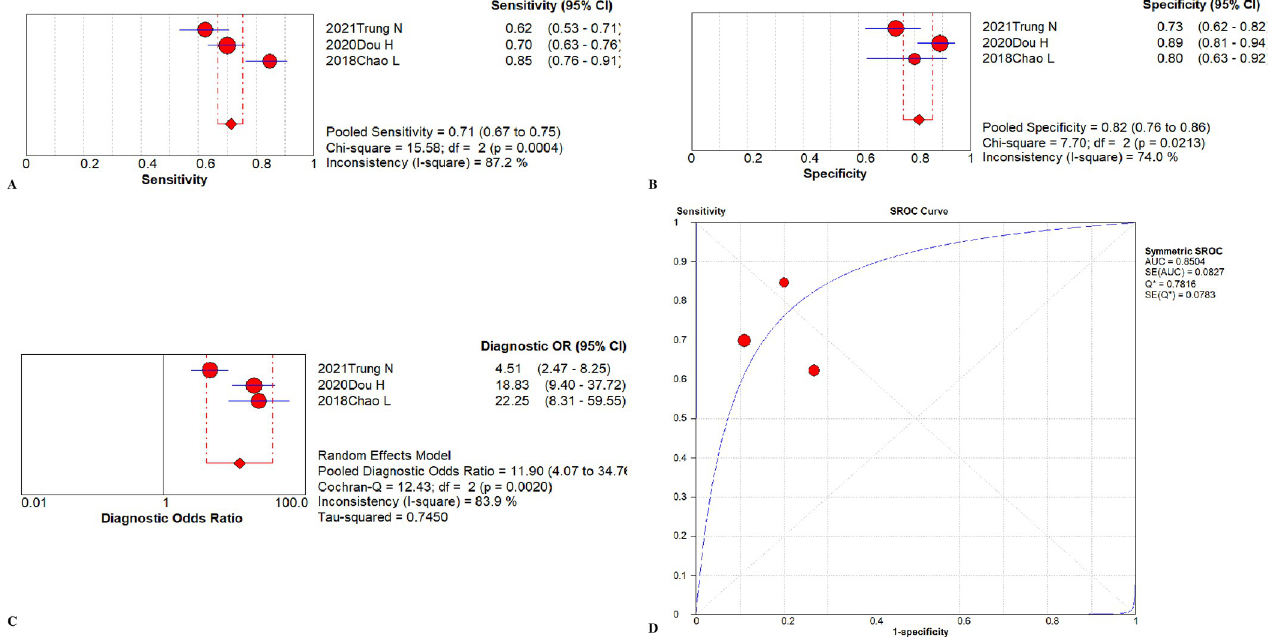
Fig 5. Performance of miR-155-5p for sepsis diagnosis. (A) Pooled sensitivity. (B) Pooled specificity. (C) Overall DOR. (D) The SROCs for all datasets. CI = confidence interval, DOR = diagnostic odds ratio, miR = mircoRNA, OR = odds ratio, SROC = summary receiver operating characteristic curves value.